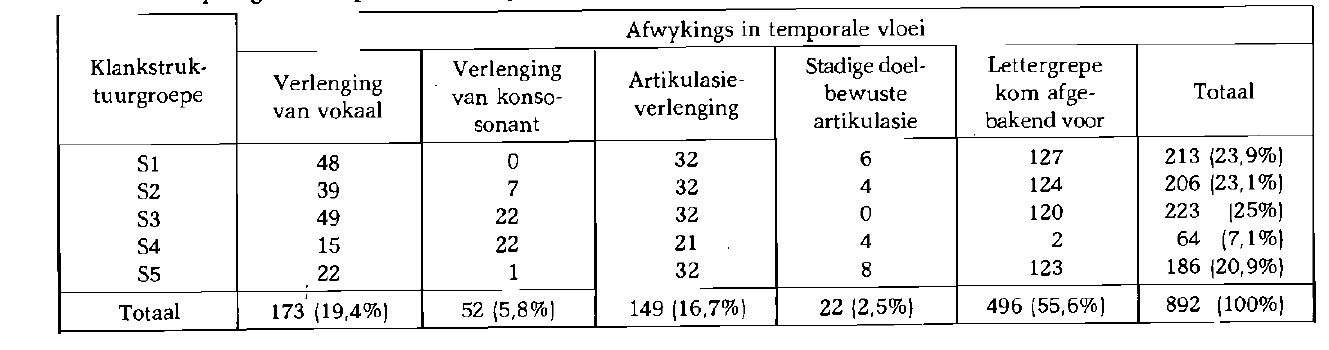
Tabel 4: Afwykings in temporale vloei by die verskillende